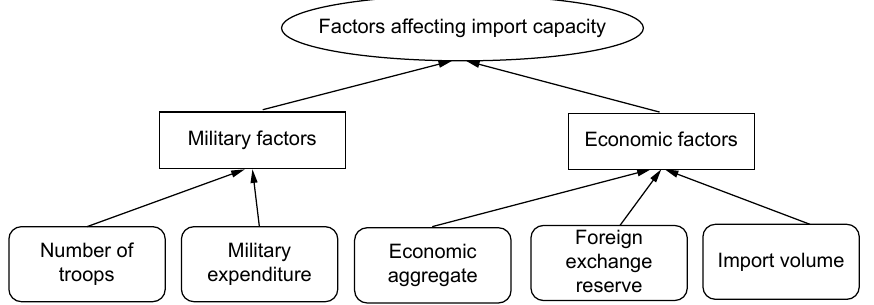
Fig. 4 Structural model of international relations with material-exporting